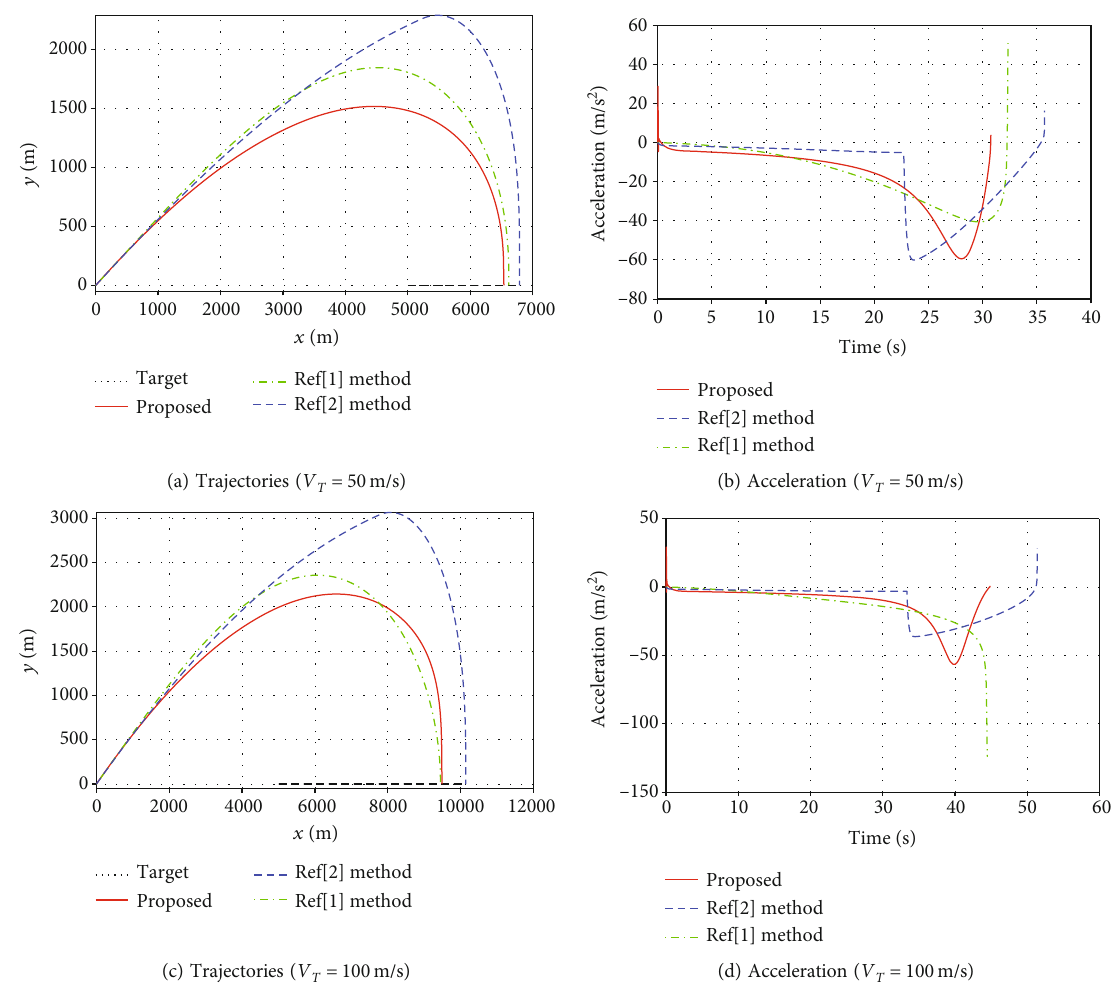
Figure 9: Case III: constant velocity target. Table 7: Simulation result for Case